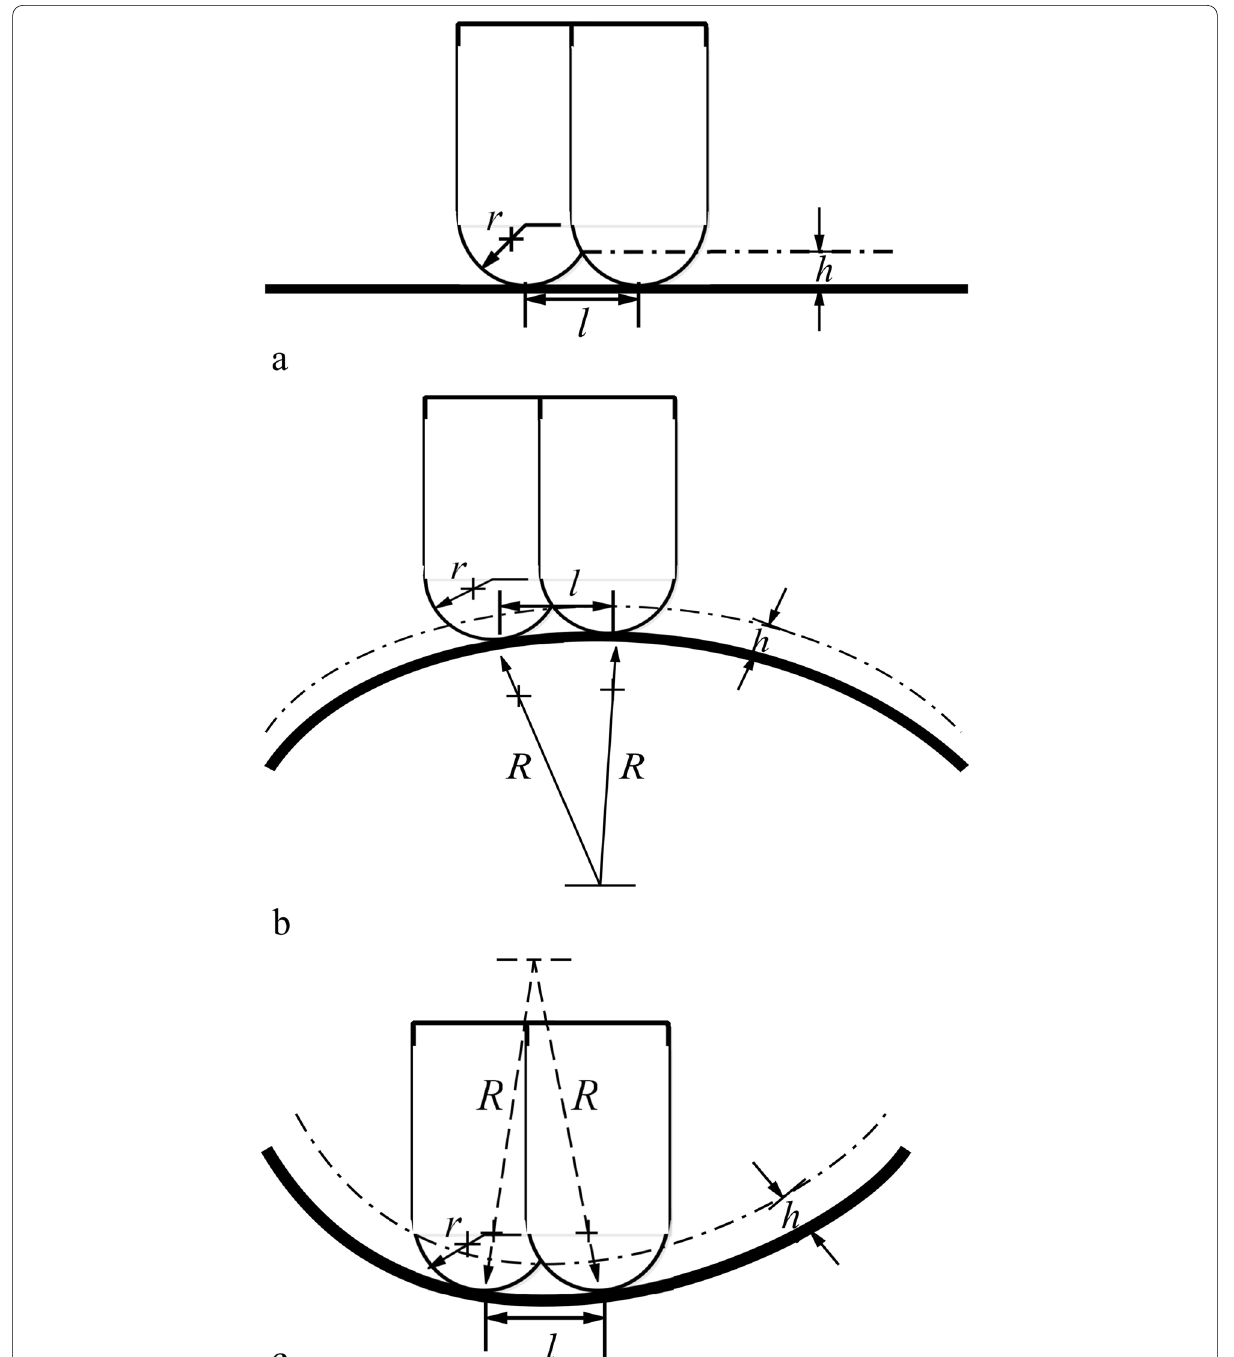
Fig. 14 Path intervals on three different surfaces. a Path interval on flat plane; b Path interval on a convex surface; c Path interval on concave